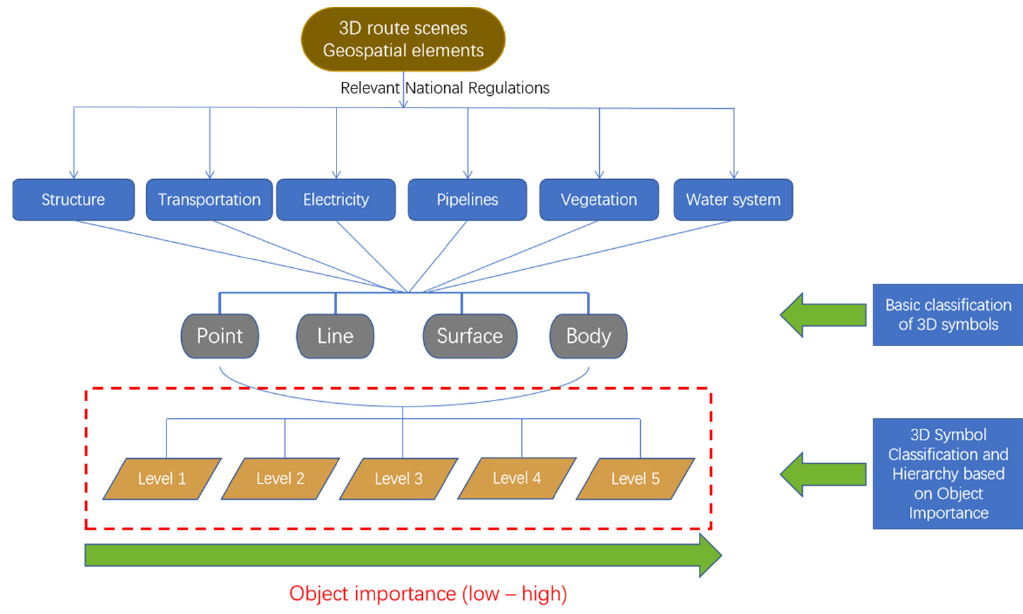
Figure 3. Flowchart: 3D symbol classification and hierarchy.